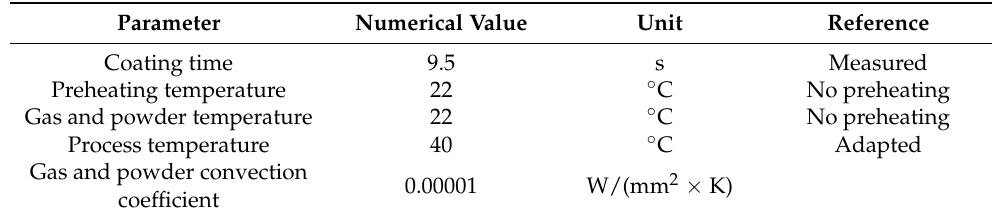
Table 3. Setup for the process simulation.